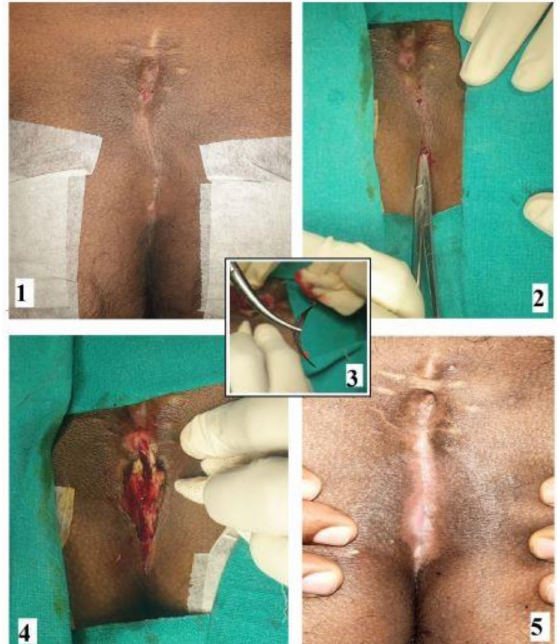
Figure 1. LOCULA (lay open with curettage under local anesthesia) in a 27-year-old male patient with recurrent pilonidal sinus who had undergone wide excision and midline closure previously. ( 1 ). Preoperative photo, ( 2 ) A curved artery forceps is inserted into the sinus cavity, ( 3 ) A bunch of hairs being removed from the cavity, ( 4 ) Final postoperative wound, ( 5 ) Complete healing of the wound after seven